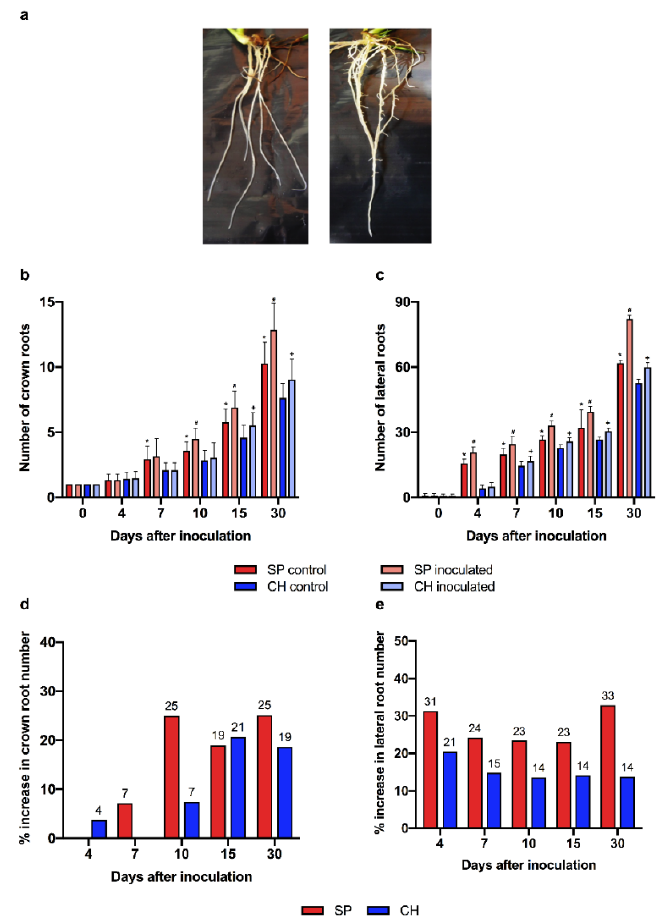
Figure 8. Analysis of roots between the contrasting genotypes grown in hydroponics. ( a ) Repre- sentative photos of diazotrophic-free plants grown four days after transfer to hydroponics demonstrate the differences observed in the quantitative analysis of control plants. Evaluation of crown ( b ) and ( c ) lateral roots, and % of increase in ( d ) crown and lateral root number ( e ) in plants inoculated with G. diazotrophicus . Analyses were performed 0, 4, 7, 10, 15 and 30 days after inoculation. The symbol (*) indicates significant differences between SP and CH control plants at the same time point. The symbol (#) indicates significant differences between control and inoculated plants of the same genotype at the same time point. The (+) sign indicates significant differences between SP and CH inoculated plants at the same collection point. Bars indicate mean ± standard error of three independent experiments.